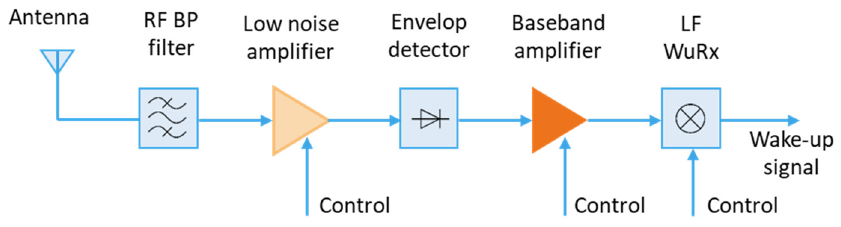
Figure 9. Block diagram of WuRx.